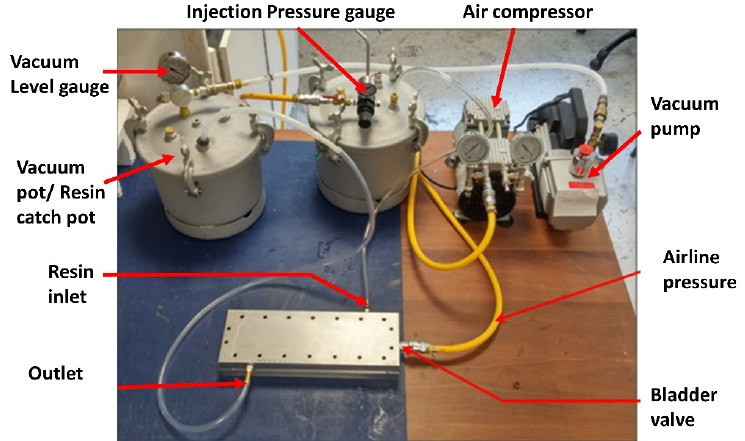
Figure 9. B-RTM setup for manufacturing a tubular section.